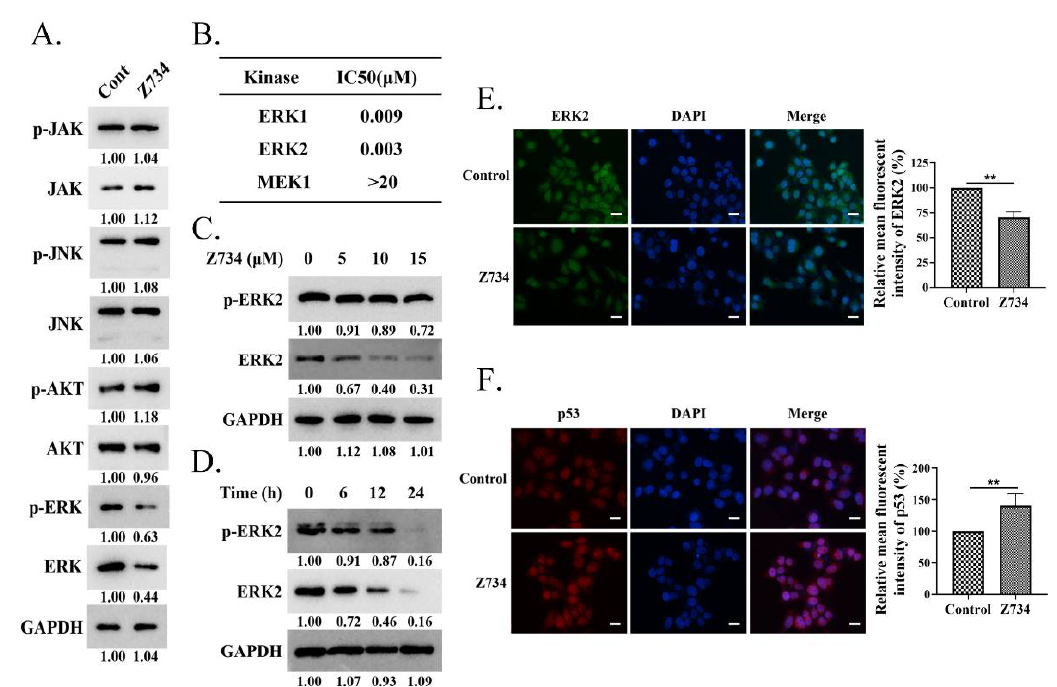
Figure 2. Z734 downregulates the expression of ERK2 in MCF–7 cells. ( A ) MCF–7 cells were treated with Z734 (10 µ M for 12 h). The expression levels of p–JAK, JAK, p–JNK, JNK, p–AKT, AKT, p–ERK, ERK, and GAPDH were determined via Western blotting. ( B ) Effects of Z734 on kinase activity of ERK1, ERK2, and MEK1. ( C ) Western blot analysis of the p–ERK2 and ERK2 expressions in MCF–7 cells exposed to 0, 5, 10, and 15 µ M of Z734 for 12 h. Relative protein expression was normalized to GAPDH. ( D ) Western blot analysis of the p–ERK2 and ERK2 expressions in MCF–7 cells treated with Z734 (10 µ M) for 0, 6, 12, and 24 h. ( E , F ) MCF–7 cells were exposed to Z734 (10 µ M) for 12 h and were then stained with antibodies for ERK2 and p53. DAPI was used to stain the nuclei. Images were obtained using a fluorescence microscope. Quantification of fluorescence was performed on the average optical density using the ImageJ software. Scale bars = 10 µ m. Data shown in ( E , F ) were used two–tailed Student’s t –test. All assays were performed in triplicate, and the data are expressed as mean ± standard deviation. ** p <